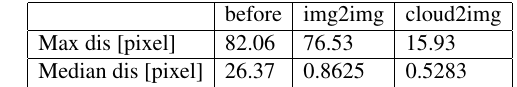
Table 2. Coregistration results based on image coregistration in method 1 and 2. Quality for the projected lines is significantly better than for original